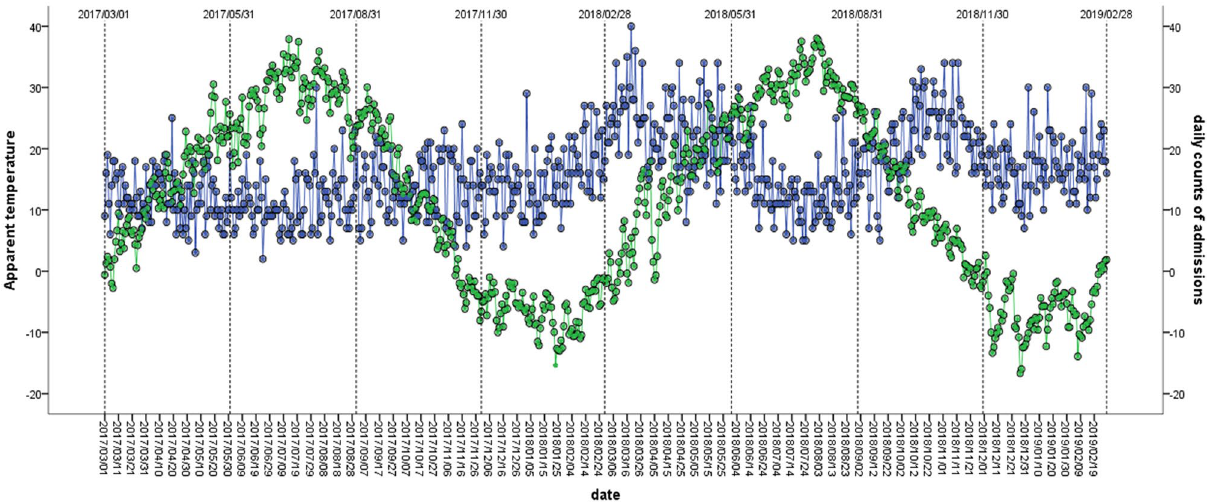
Figure 1. Seasonal distribution of daily hospital admissions due to acute cardiac events and apparent temperature in 10 hospitals in Beijing between 1st March 2017 and 28th February 2019. *Green points indicate apparent temperature; blue points indicate daily admission for acute cardiac